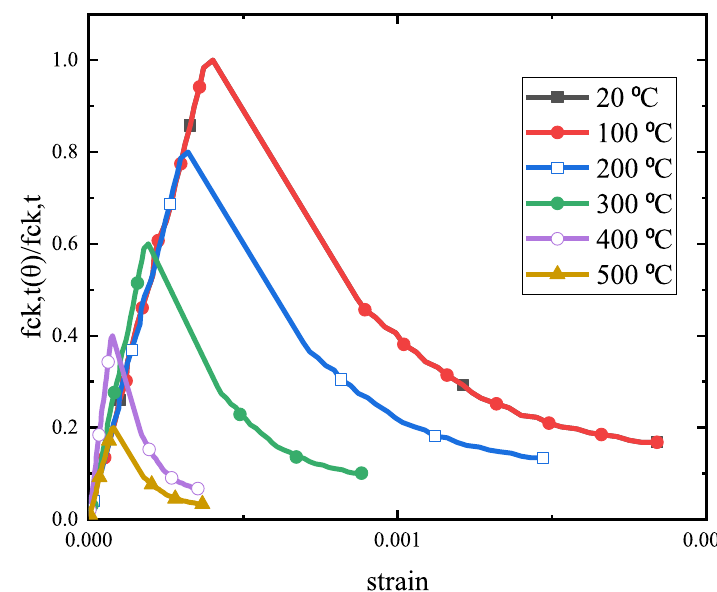
Fig. 16 Stress-strain relationship of concrete in tension at elevated temperatures [20,